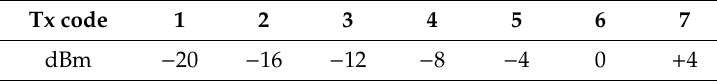
Table 1. Transmitter power ( Tx ) codes in both brands of beacons.